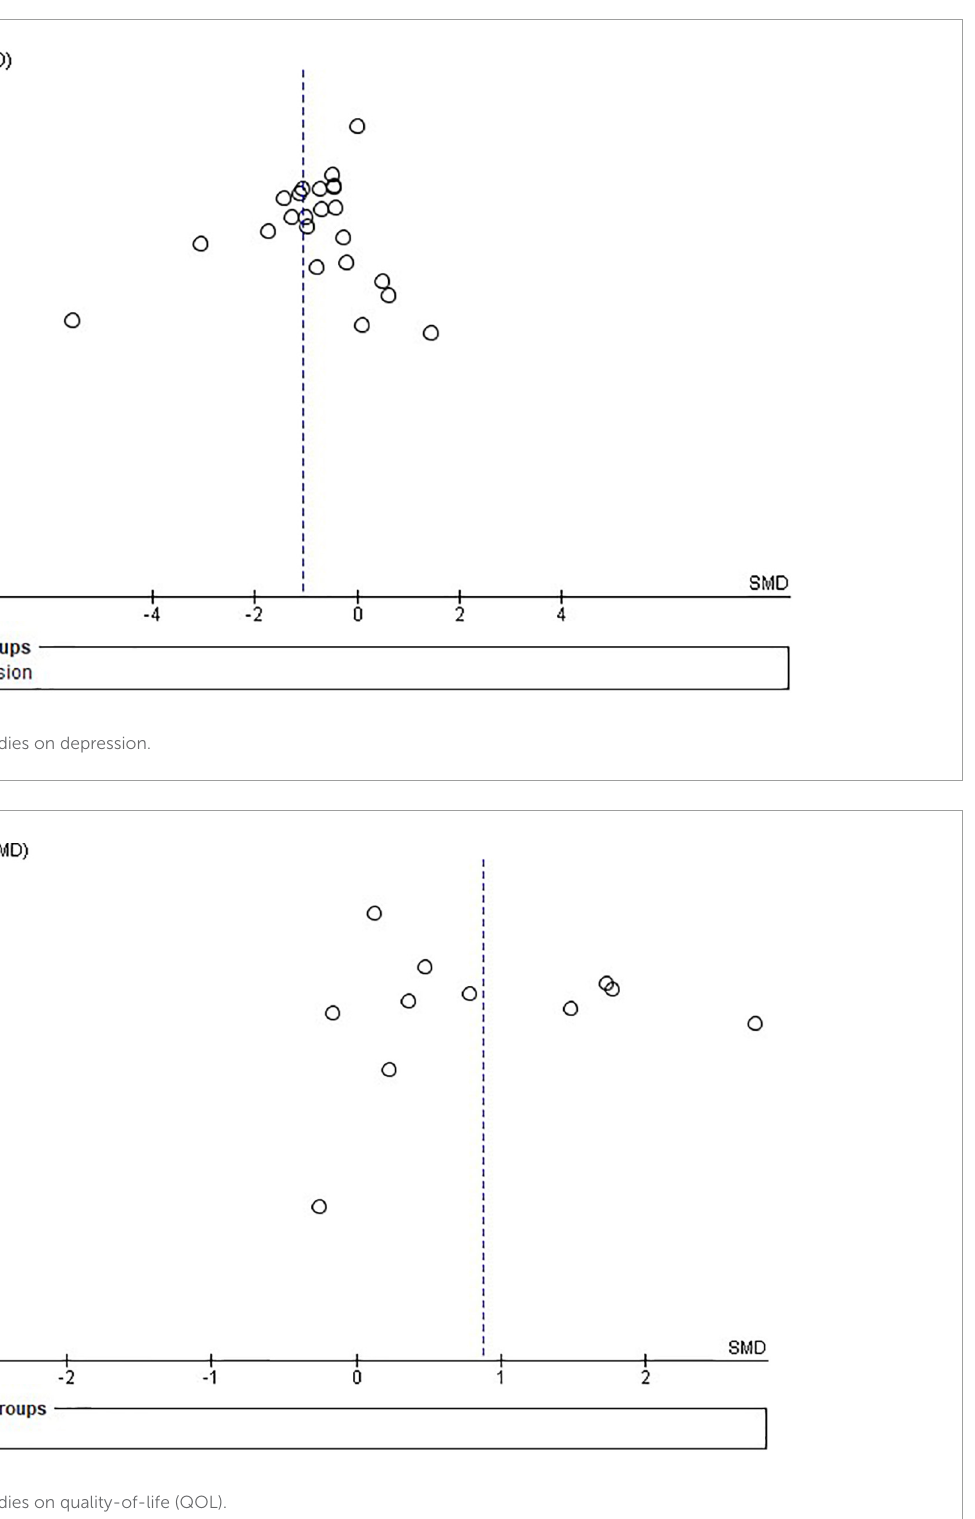
impending death. Third, studies that used four multi-dimensional measurement tools were not included in the meta-analysis. This could bring a risk of bias due to missing results in